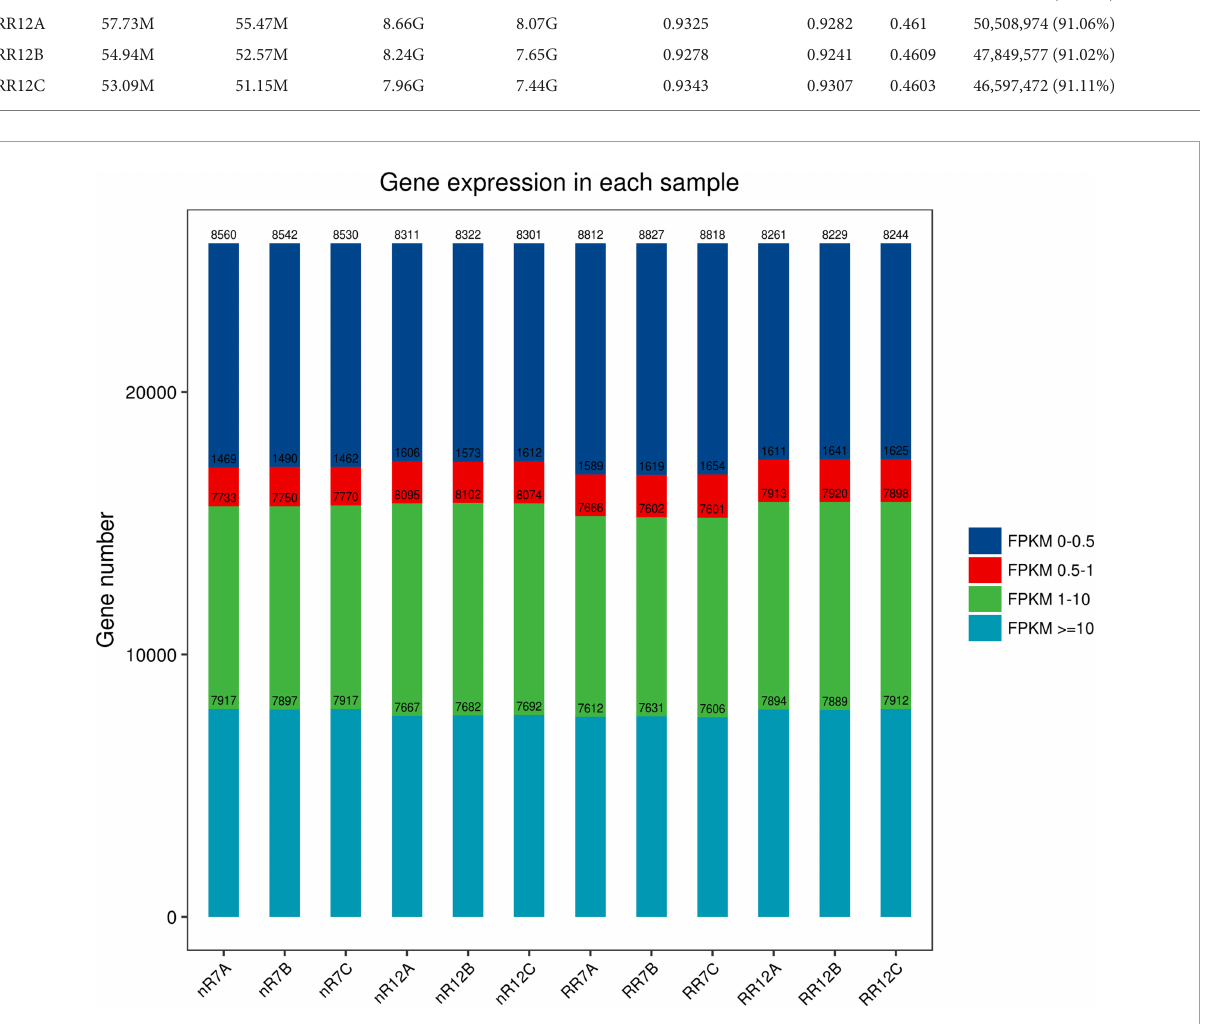
FIGURE1 The distribution of FPKM expression in nR7, RR7, nR12, and RR12 represent at the 70 DAP (days after planting days) and 125 DAP sampling points under nR and RR cultivation. A total of four FRKM were classified in this study, including FRKM 0–0.5, FRKM 0.5–1, FRKM 1–10, and FRKM ≥ 10.